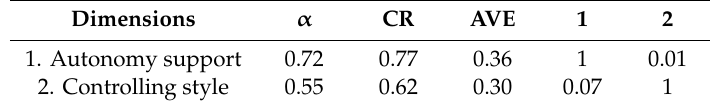
Table 2. Reliability, bivariate correlations, and discriminant validity between the variables that conform the Interpersonal Styles Questionnaire for Physical